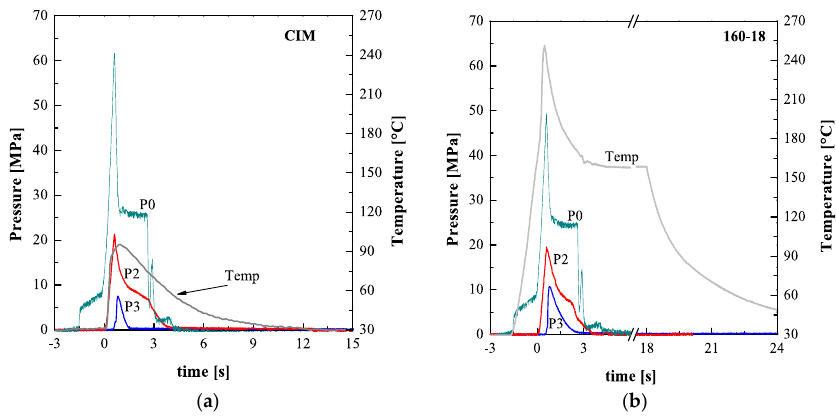
Figure 2. Pressure and temperature evolutions measured during the injection molding experiments conventional injection molding (CIM) ( a ) and 160-18 ( b ).